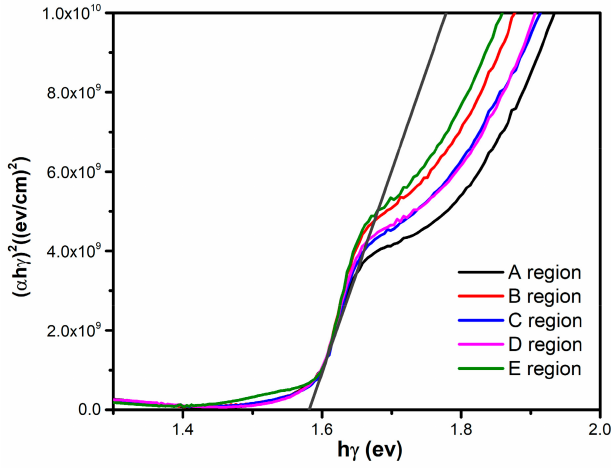
Figure 9. Optical band gap estimation of A, B, C, D and E regions of large-area perovskite MAPbI 3 thin